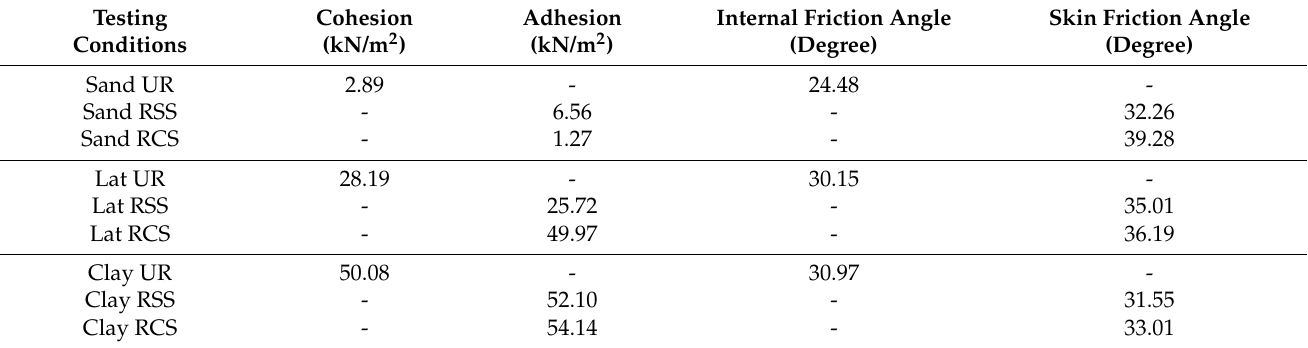
Table 4. Cohesion, internal friction angle, adhesion, and skin friction angle for all soil